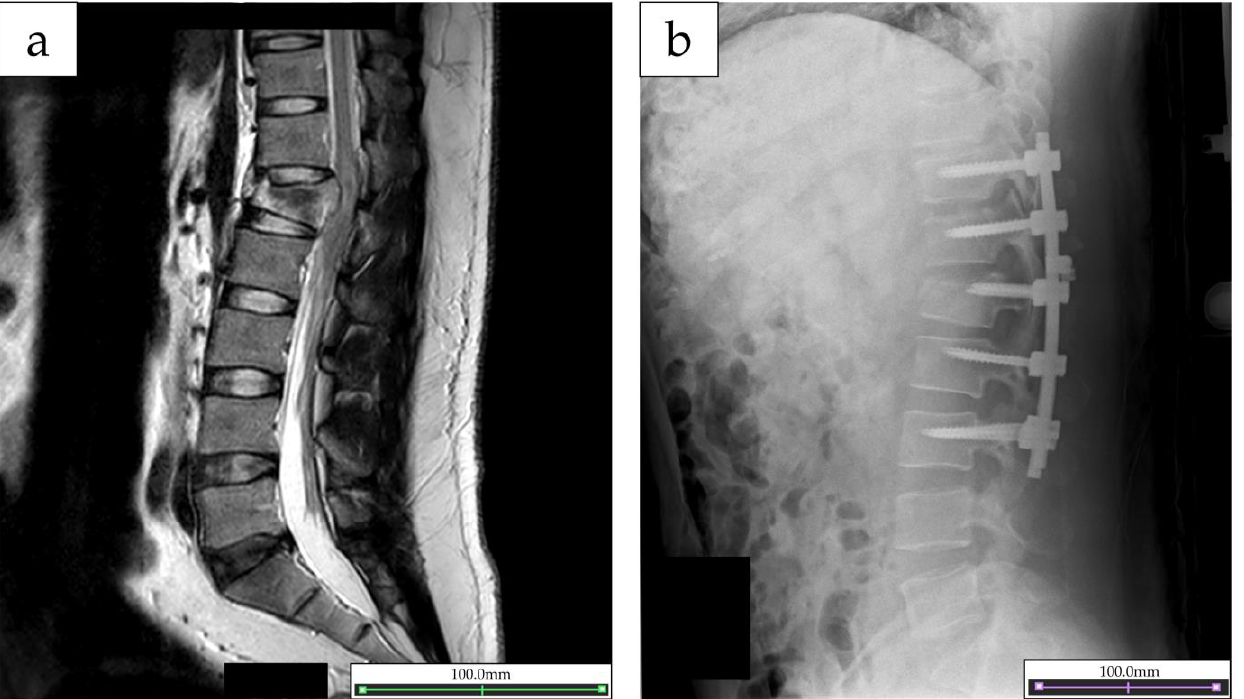
Figure 1. ( a ) Magnetic resonance imaging images of the lumbar spine and spinal cord taken on the date of injury. ( b ) X-ray image after posterior spinal decompression fusion.